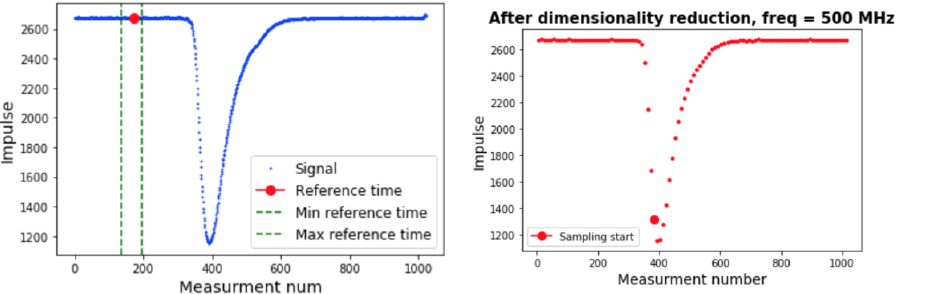
Figure 3. Signal sampling before (left) and after dimensionality reduction